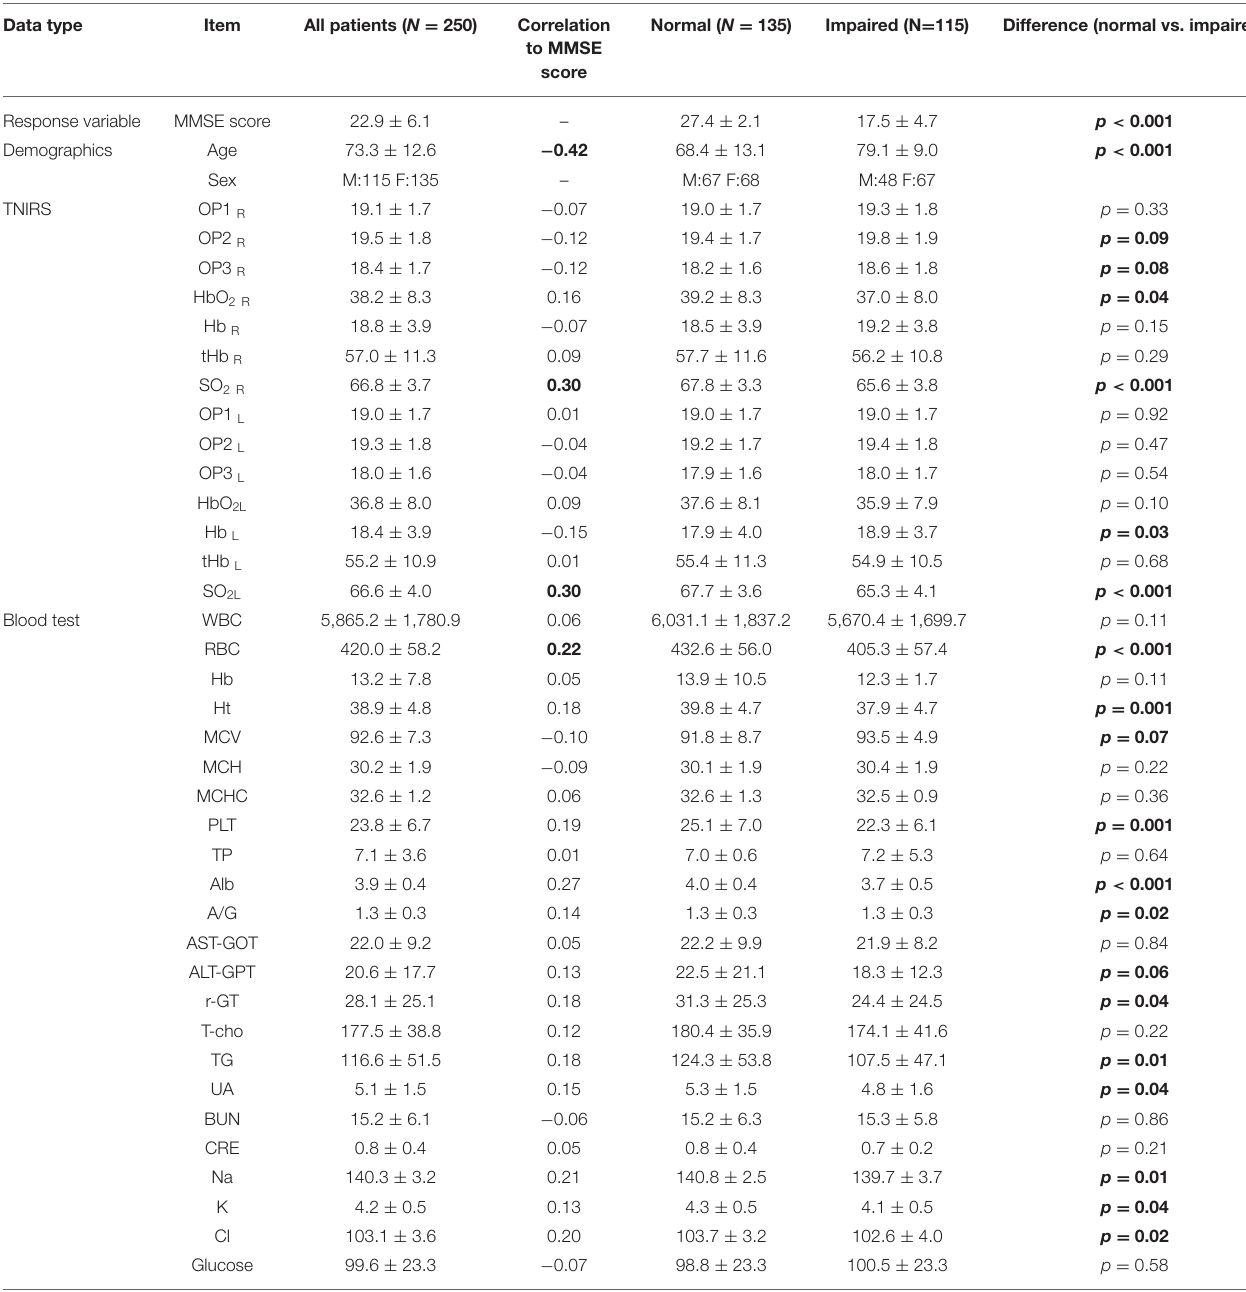
TABLE 2 | Measured